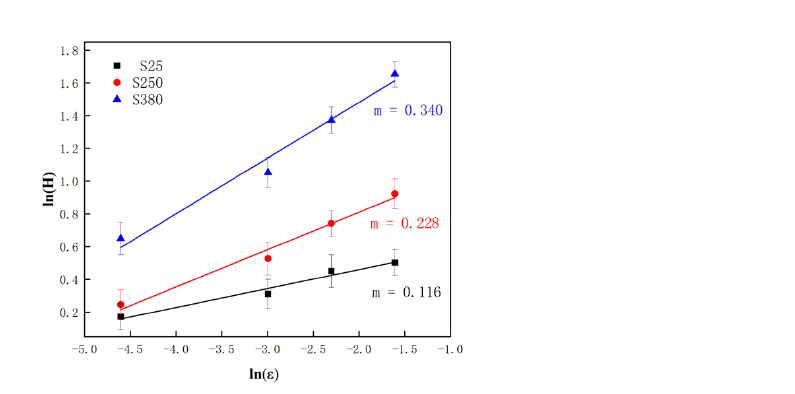
Figure 8. Force-depth curves ( a ) and hardness ( b ) of S25, S250, and S380 by nanoindentation with a loading rate of 0.2 mN/s.